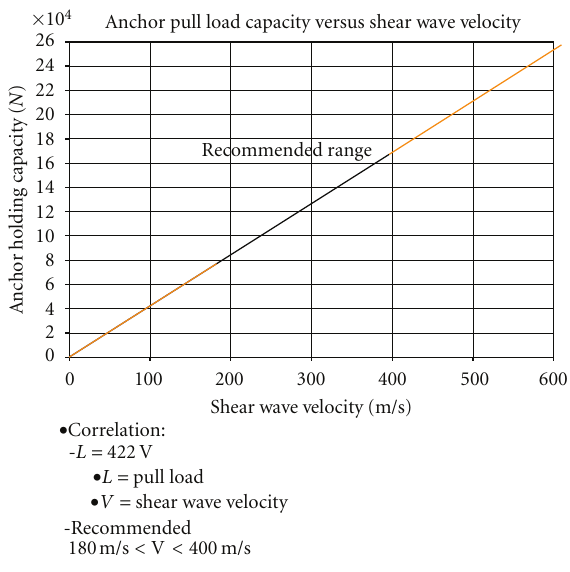
Figure 8: Recommended range for anchor pull load capacity versus shear wave